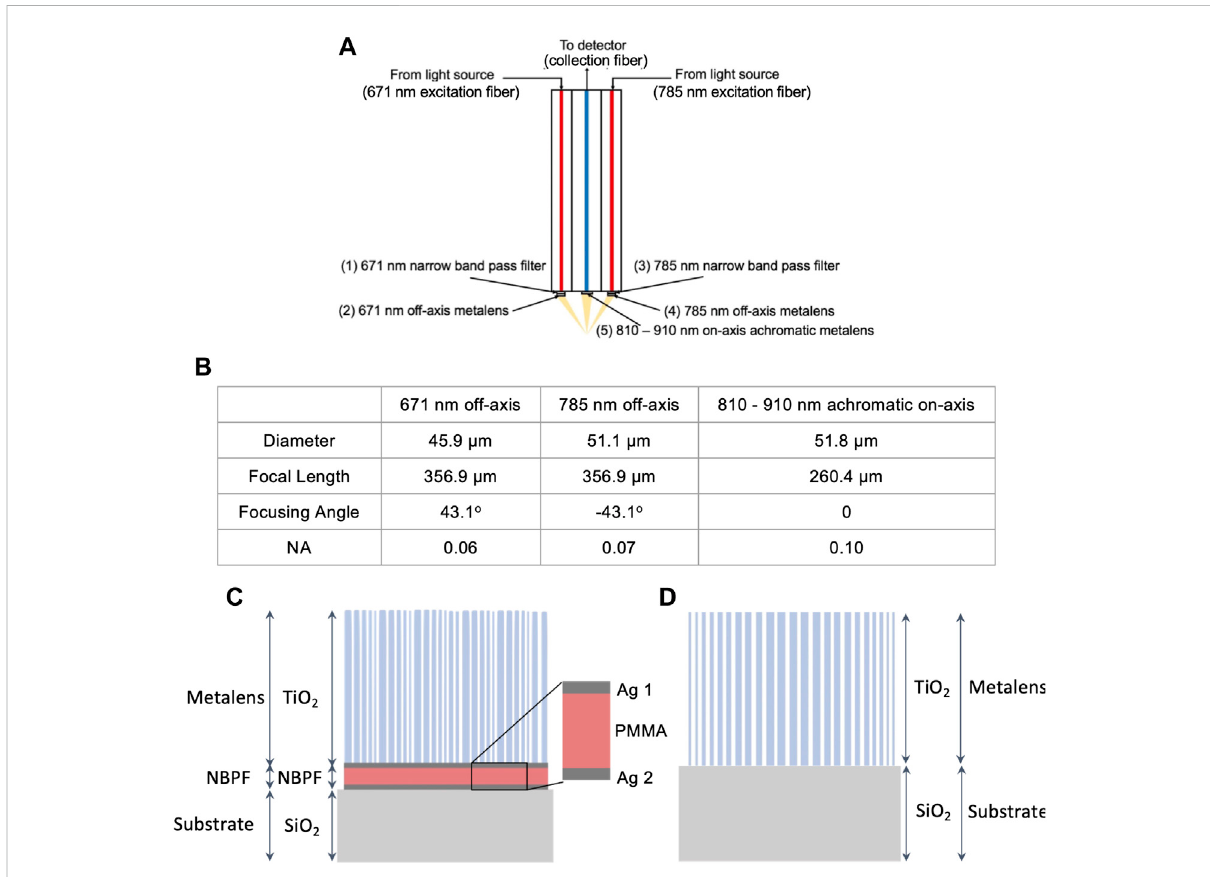
FIGURE 2 Schematic of new Raman probe and metasurfaces. (A) Schematic of new Raman probe, which consists of two excitation fi bers (671 and 785 nm),onecollection fi ber,aswellas fi vemetasurfaces — 1)671 nmnarrowbandpass fi lter(NBPF),2)671 nmoff-axismetalens,3)785 nmNBPF,4) 785 nm off-axis metalens, 5) 810 – 910 nm on-axis achromatic metalens. (B) Speci fi cations of metalenses — Diameter, Focal Length, and Numerical Aperture (NA). (C) Schematic of off-axis metalens and NBPF — consisting of the SiO 2 substrate, NBPF, and off-axis metalens comprising of TiO